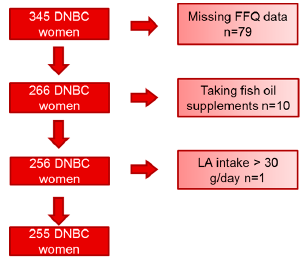
Figure 2. Participant exclusion chart. DNBC; Danish National Birth Cohort; LA: linoleic acid.